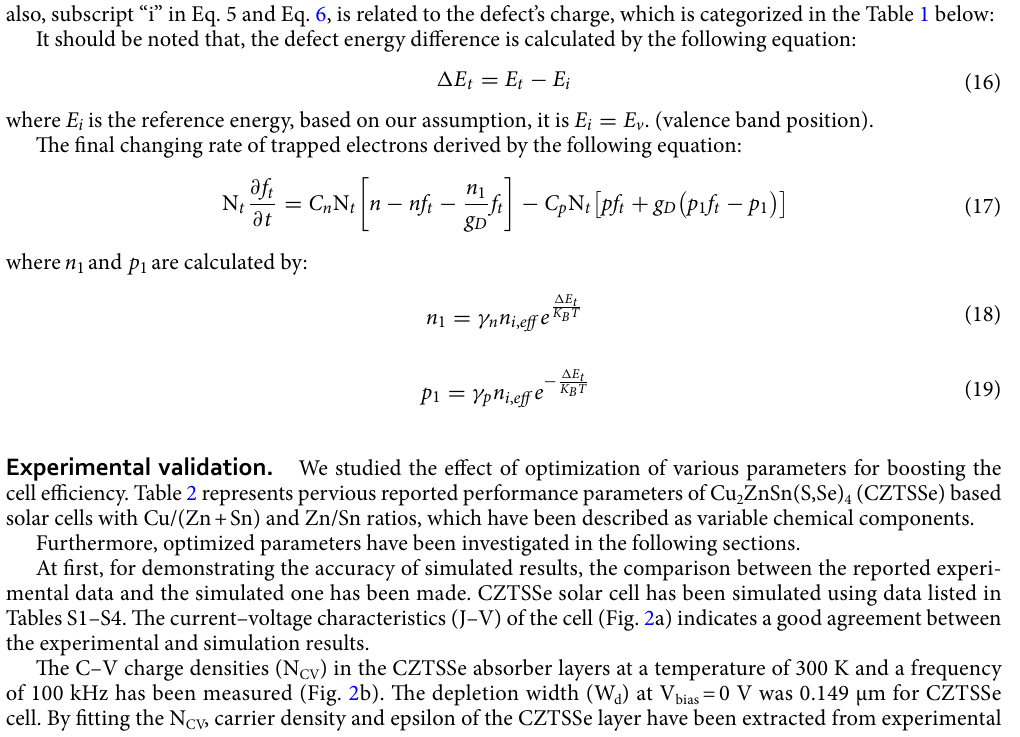
where ϕ B 0 is the potential barrier in the front contact, W F is the metal work function of the front contact, and χ